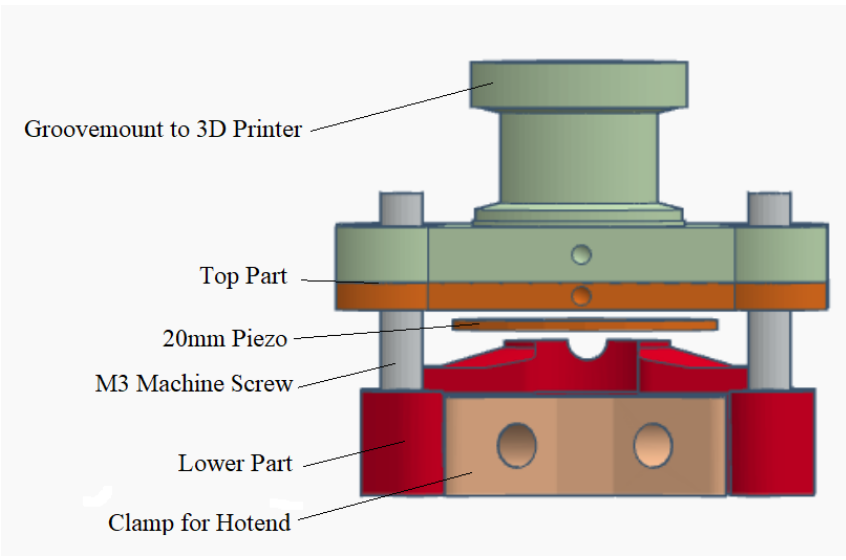
Figure 10. Piezo Z